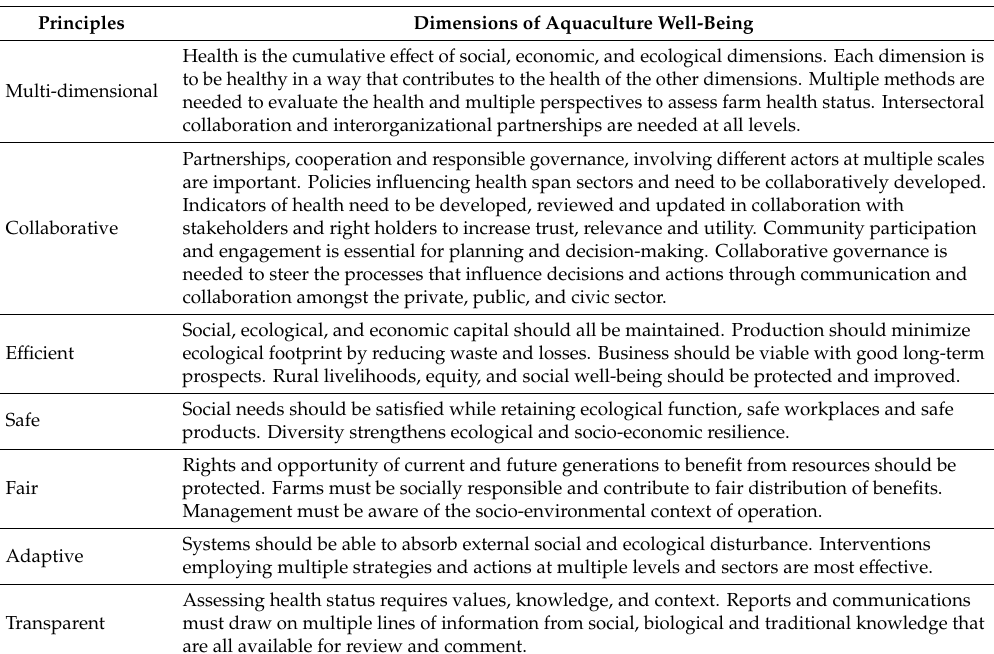
Summary of the principles of agroecosystem management and health including a socio-ecological approach to human health informing a conceptual model of an aquaculture index of